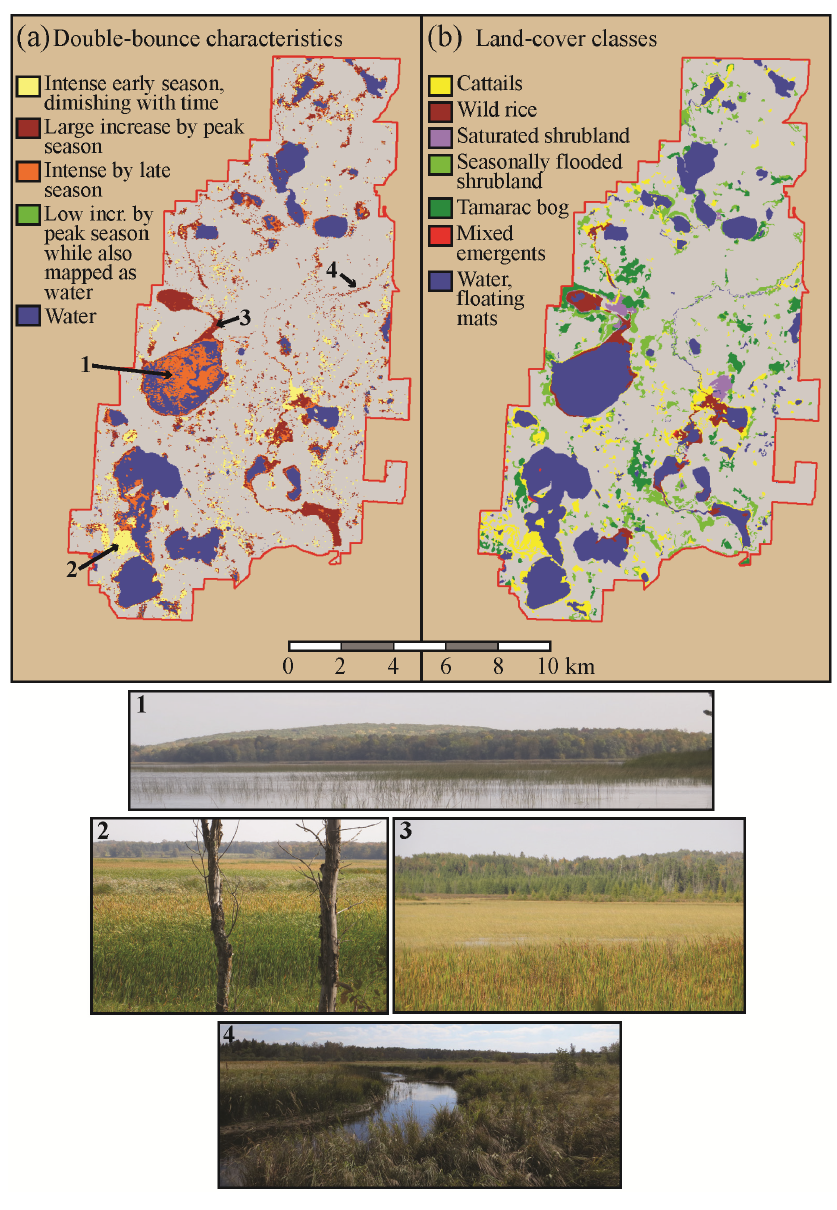
Figure 9. SAR seasonal summary map for 2009 ( a ) and the land-cover map developed from 2005 data ( b ). These maps show how the spatial distributions for different temporal characteristics of double-bounce backscatter compare with the distributions of wetland vegetation types from the land-cover map. Photo 1—bulrush; photo 2—large stand of cattails; photo 3—expanse of wild rice edged with narrow strips of cattails; photo 4—mix of wild rice and cattails established along a